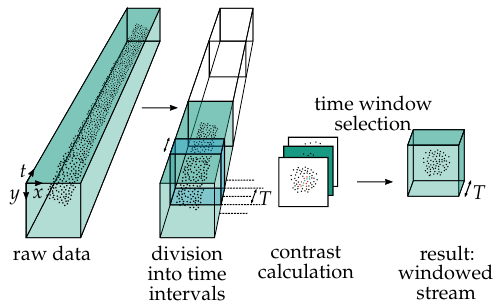
Figure 3. Windowing method to reduce the event stream to the time interval with the highest contrast. The whole event stream is divided into equal time intervals. Within each interval a sliding time window is used to select events for contrast calculation. The contrast is defined as the sum of events of different polarity in a spatial neighborhood. Finally, the time window with the highest contrast in each interval is selected for further